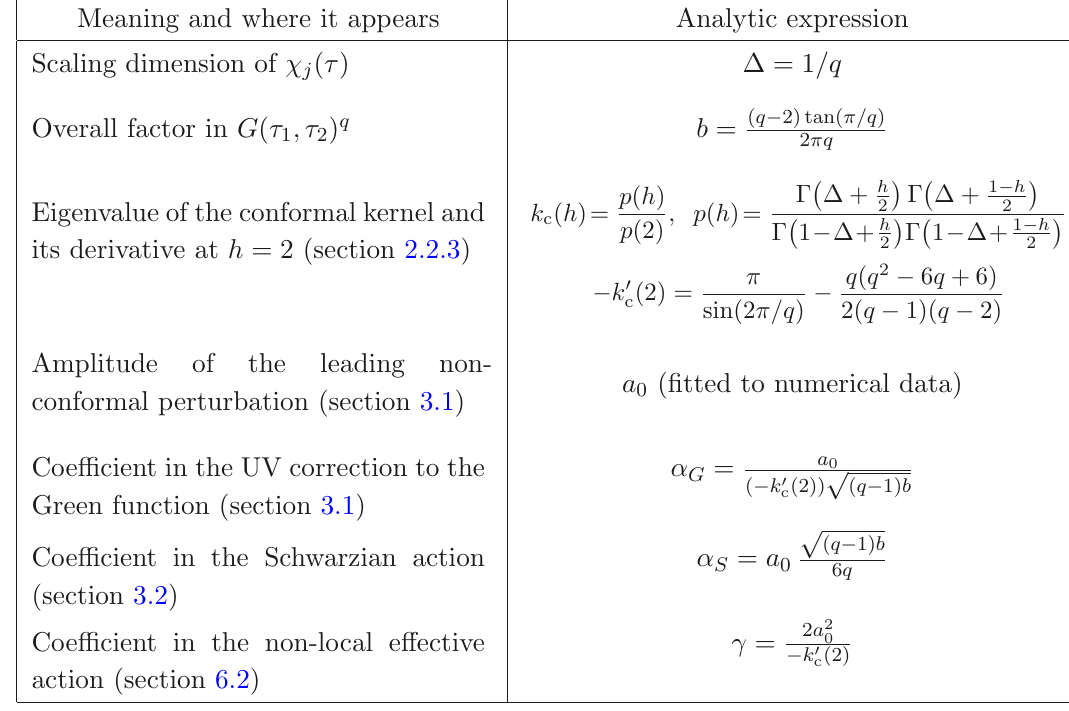
Table 1 . Common numerical coefficients and